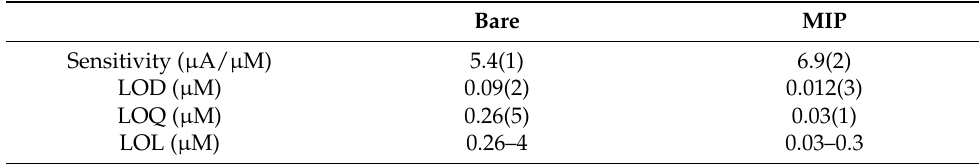
Table 7. Limits of Detection (LOD), Limits of Quantification (LOQ) and Limits of Linearity (LOL) for bare and MIP-modified screen-printed electrodes. LOD and LOQ are reported as the average of results obtained from three different calibration curves. The number in parenthesis is the standard deviation.